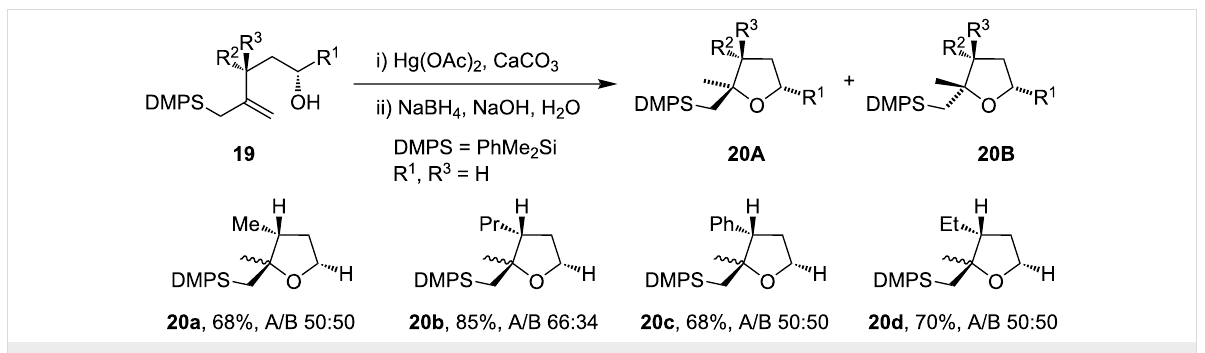
Scheme 9: Hg(OAc) 2 -mediated synthesis of tetrahydrofuran derivatives.